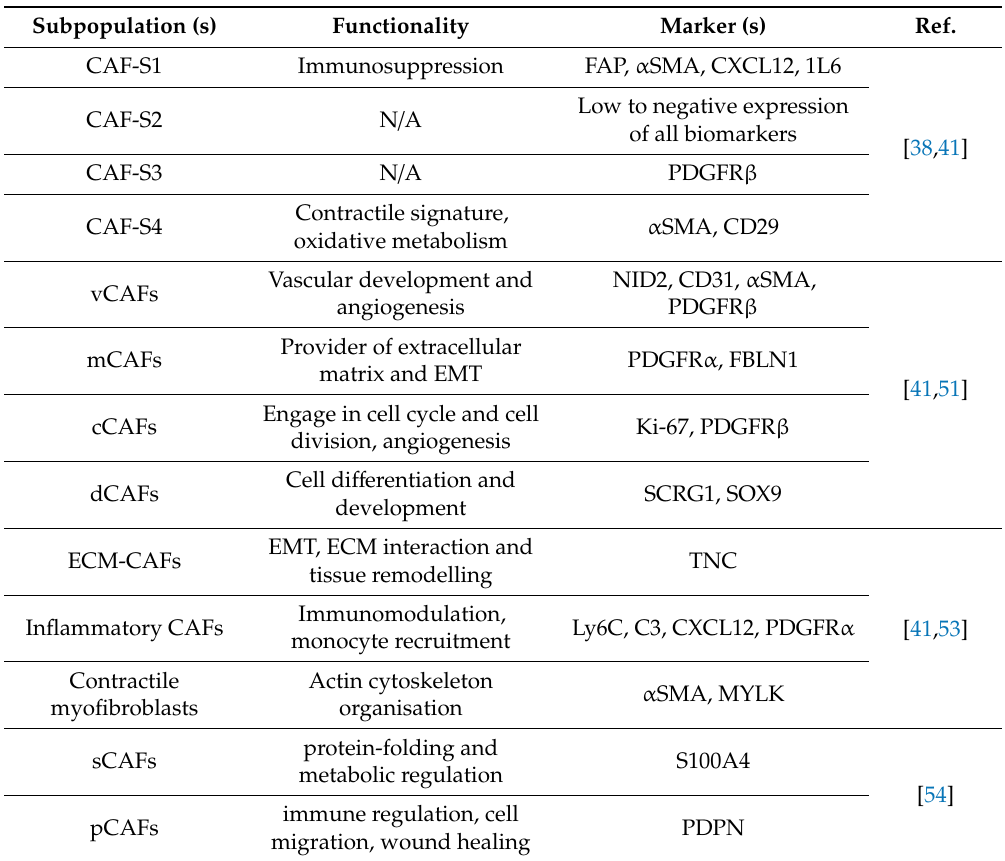
Table 1. List of BCAF subpopulations in breast